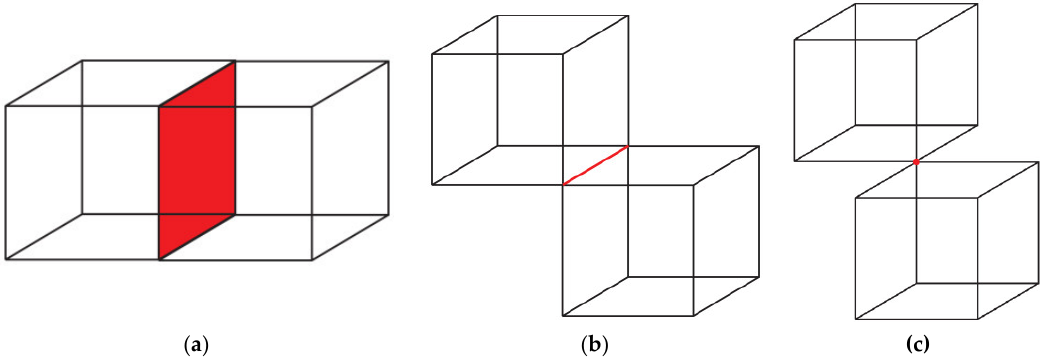
Figure 2. Indoor space grid adjacent diagram. ( a ) Face adjacent; ( b ) side adjacent; ( c ) point adjacent.